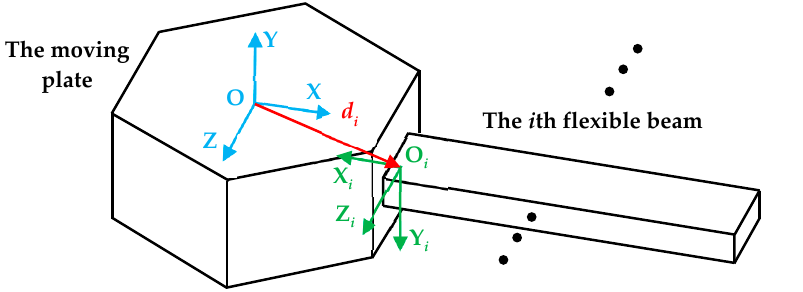
Figure 3. The moving plate connected with the i th flexible beam. Table 2. Detailed parameters of matrix T i .